Question: Name the type of graph shown.
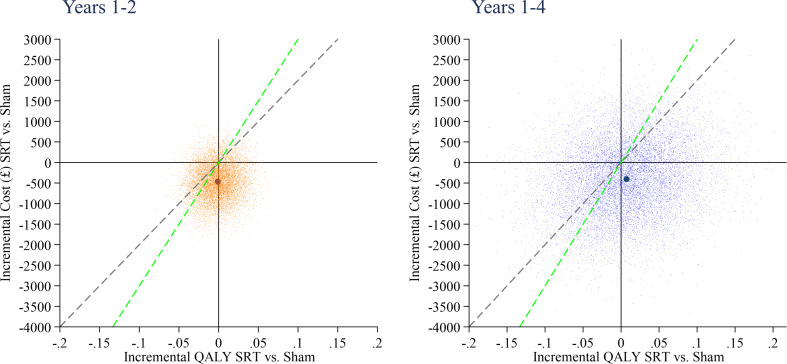
Answer: scatter